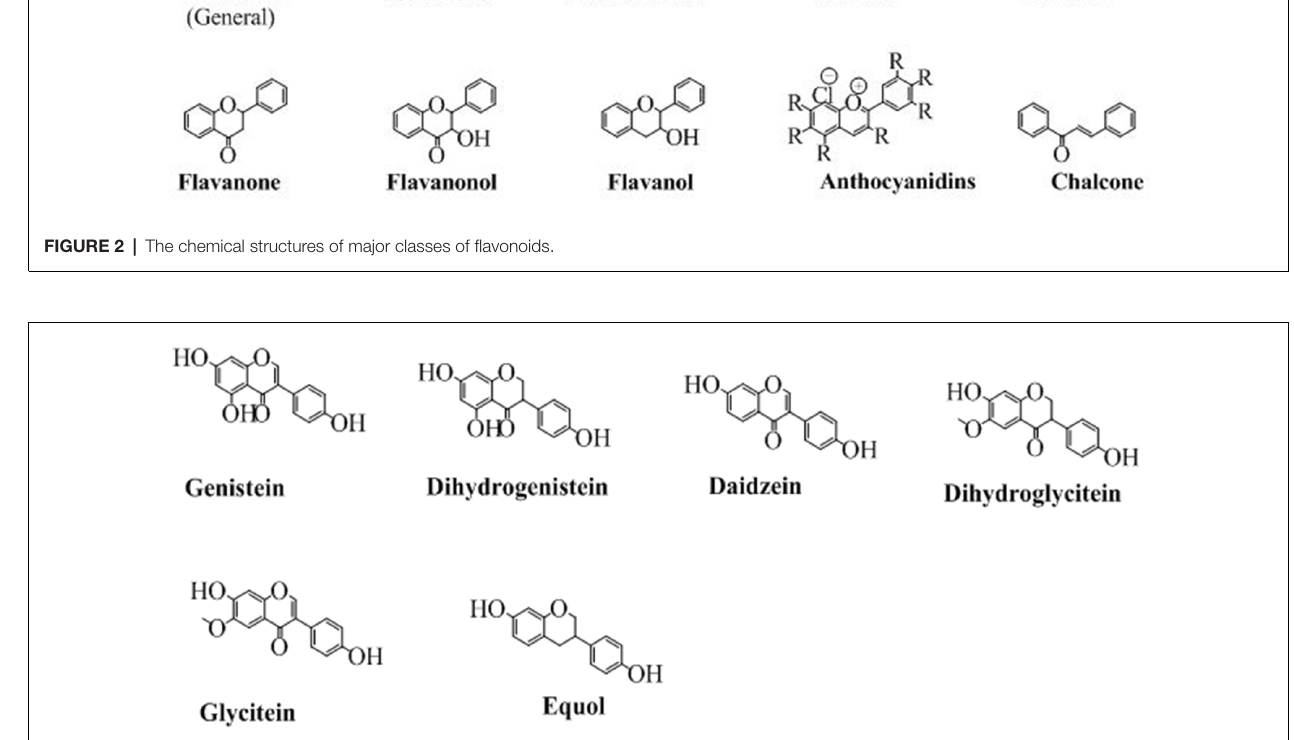
FIGURE 3 | The major isoflavones and their chemical